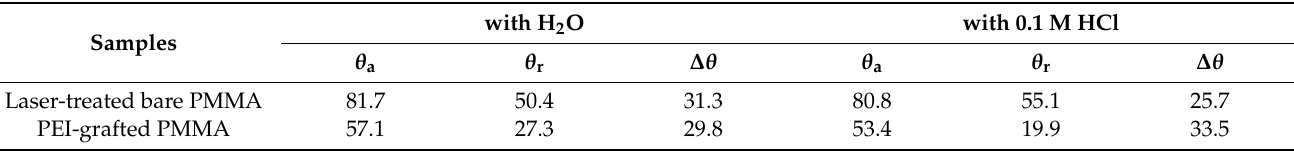
Table 4. Contact angles for laser-treated bare PMMA and PEI-grafted PMMA a .